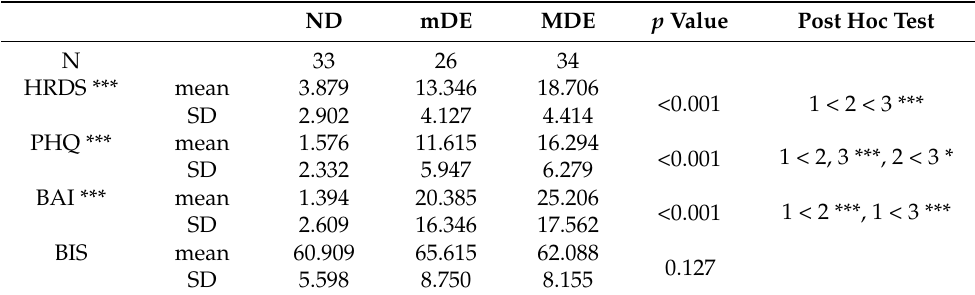
Table 2. Clinical characteristics by depressive